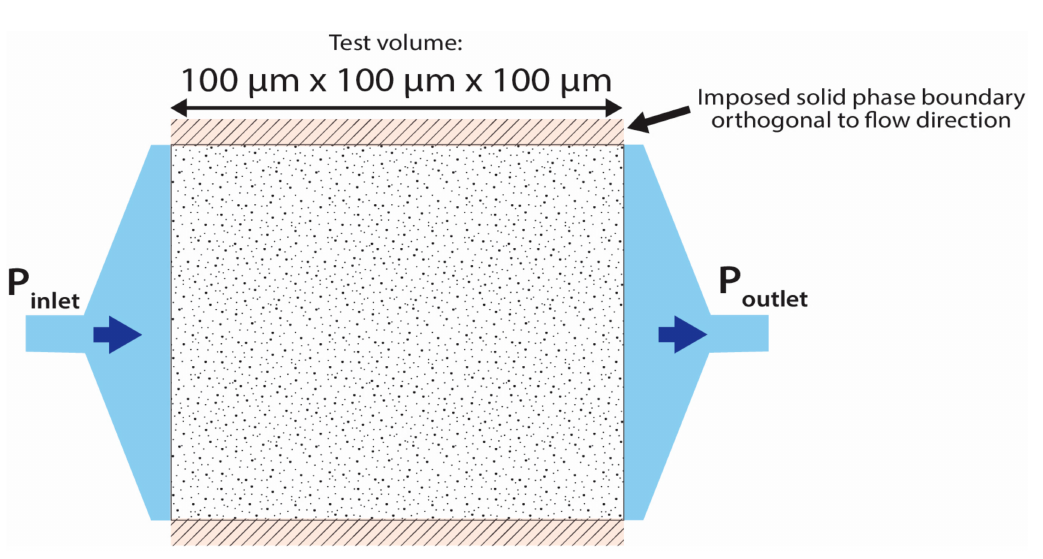
Figure 5. Schematic of permeability simulation